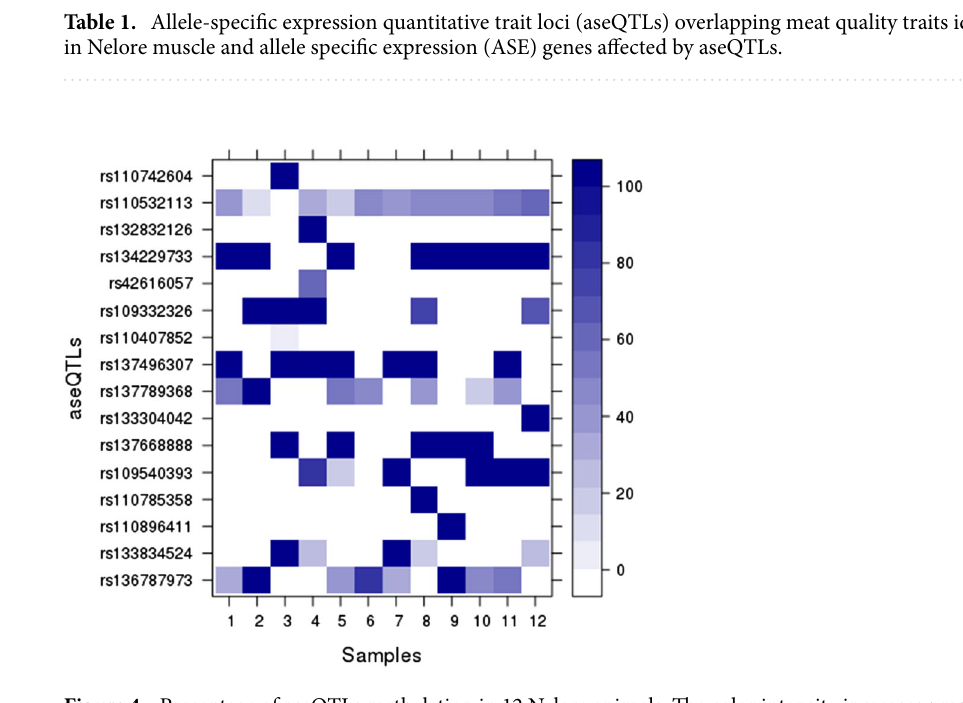
Figure 4. Percentage of aseQTLs methylation in 12 Nelore animals. The color intensity increases proportionally according to the methylation percentage for each SNP per sample. Heatmap plotted with Lattice R